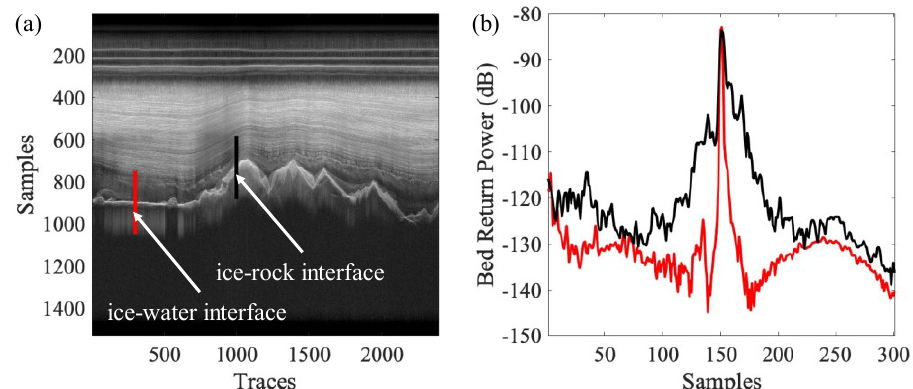
Figure 1. ( a ) A typical B-scope radargram with one clear subglacial lake in the AGAP region. ( b ) The comparison of two A-scope waveforms around the ice – water (red) and ice – rock (black) inter-